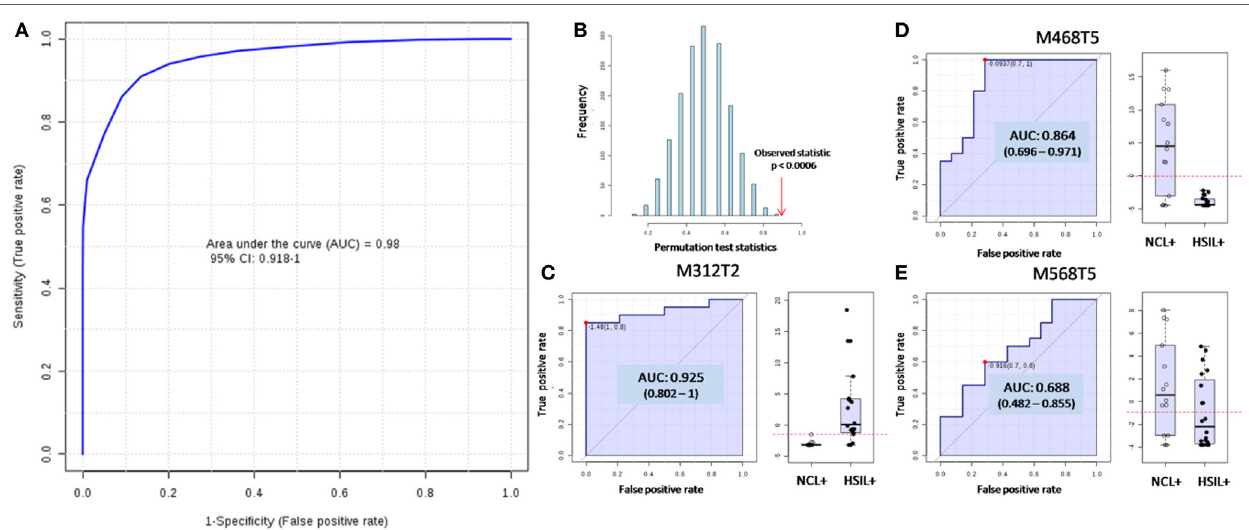
FigUre 1 | Supporting vector machine (SVM) model for differentiation of women screened positive for human papilloma virus (HPV) and who were diagnosed (i) with high-grade squamous intraepithelial lesions ( HSIL + group) and (ii) with no cervical lesion ( NCL + group) according to metabolomics. (a) The receiving operating-characteristic (ROC) curve plotting the true positive rate against the false positive rate for the model as a whole, which displayed an area under the ROC curve (AUC) of 0.98 for the test set, with average accuracy of 89.4% based on 100 cross validations. (B) The p -value was found to be significant since it is less than 0.05. The individuals ROC for the three molecules used for building the model and the relative abundances distribution of these molecules over the groups shown by the box-plots are displayed for M312T2 (c) , M468T5 (D) , and M568T5 (e)